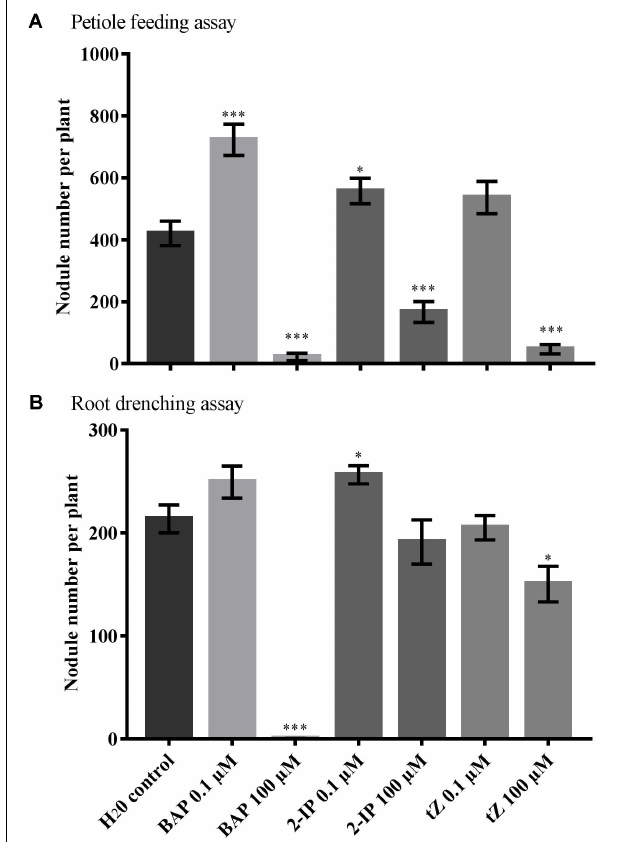
FIGURE 1 | Effect of cytokinin treatment on nodule number. Supernodulating soybean plants ( nts1116 ) were fed water (control) or cytokinin through (A) petiole feeding or (B) root drenching. Plants were inoculated with Bradyrhizobium diazoefficiens (CB1809) 1 day after the start of treatment. Nodule numbers were counted after 10 days of treatment ( n = 8). Data and error bars represent mean ± SEM. Asterisks indicate significant differences in nodule number compared with the water control (Student’s t -test, ∗∗∗ P ≤ 0.001, ∗∗ P ≤ 0.01, ∗ P ≤